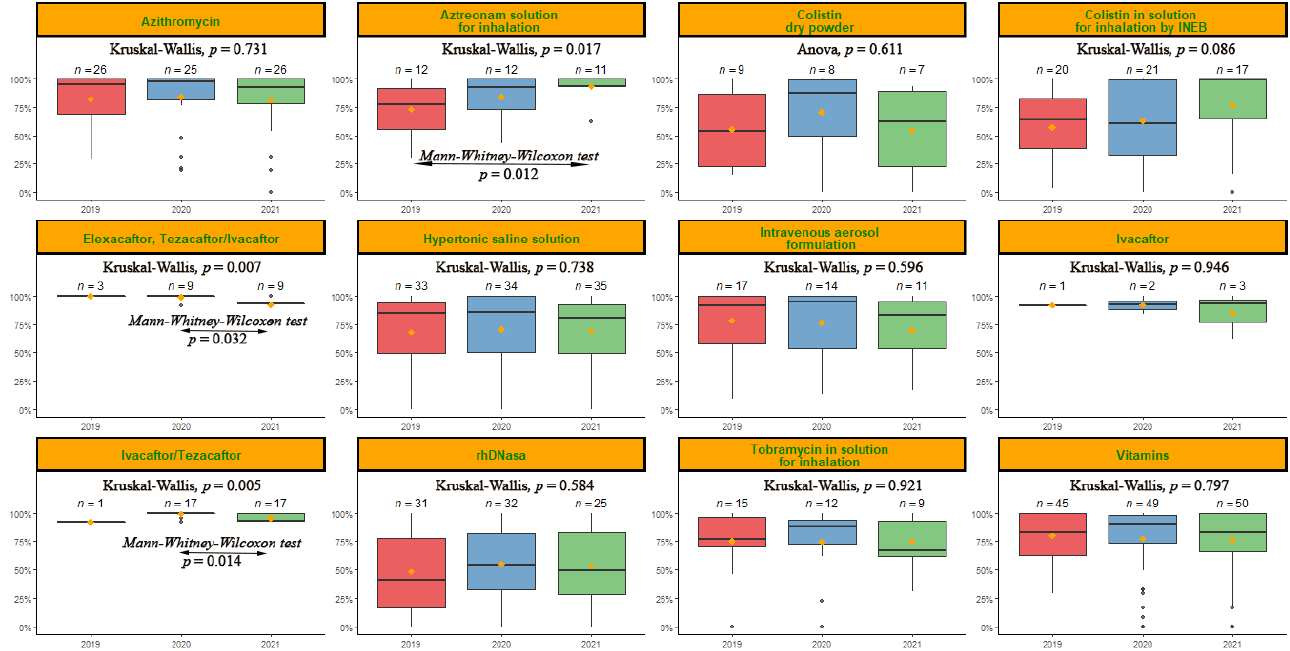
Figure 3. Compliance measured by MPR% for each treatment per year. The test used and the p -value obtained after comparing the groups are indicated above each graph. In those groups where a statistically significant difference ( p < 0.05) was obtained, a post-hoc test was conducted. The type of post-hoc test conducted and the p -value obtained from those statistically significant comparisons are indicated between arrows.